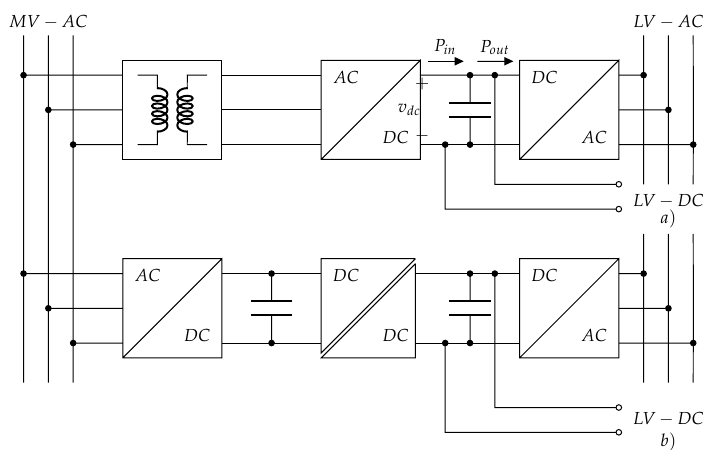
Figure 3. Schematic diagram of ( a ) a passive transformer with a back-to-back rectifier/inverter stage; ( b ) SST.